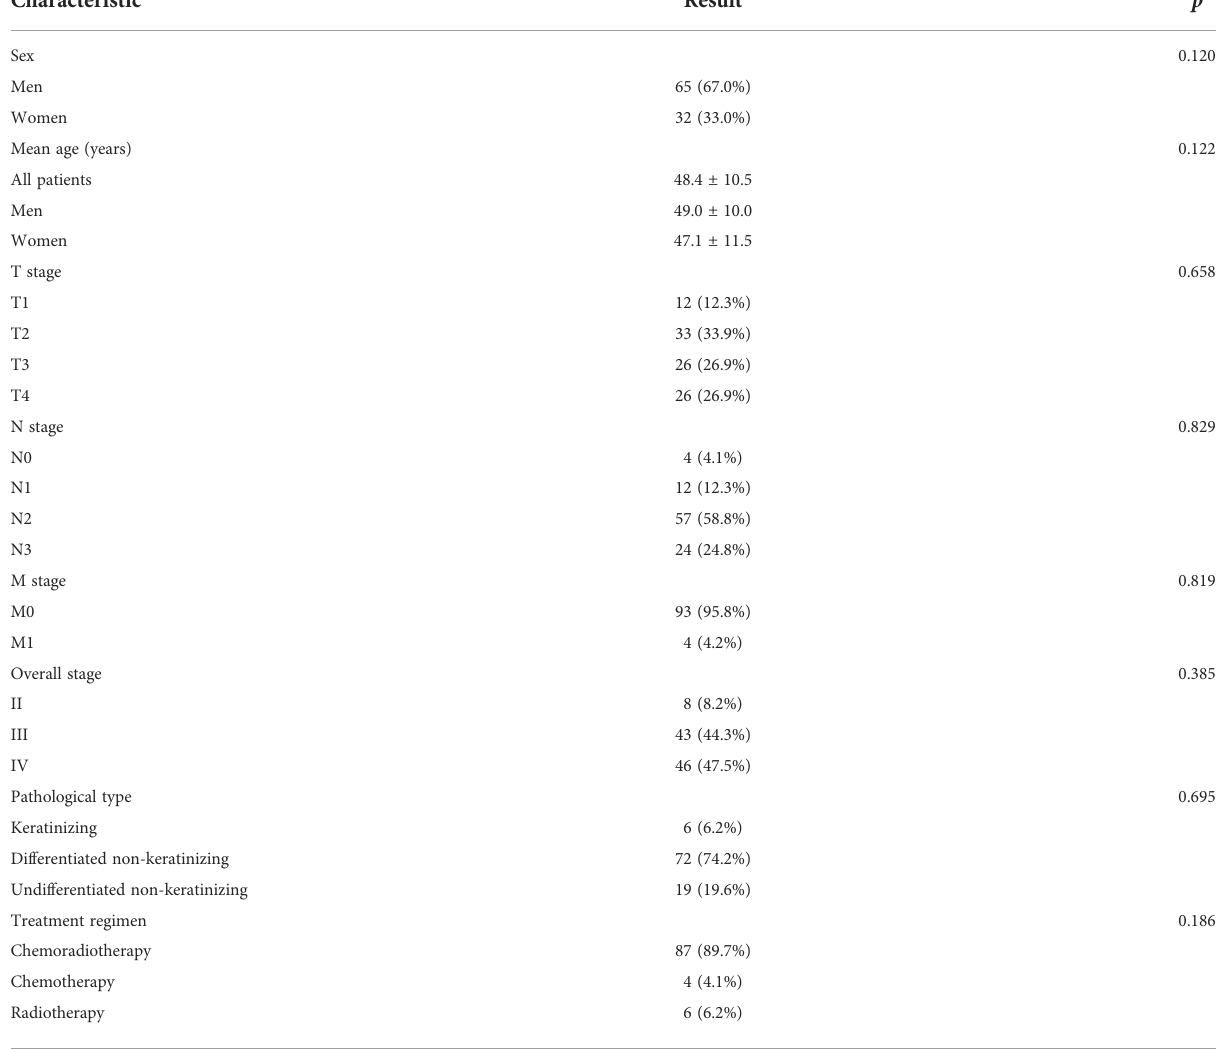
TABLE 1 Clinical and imaging features of the 97 patients with nasopharyngeal carcinoma.